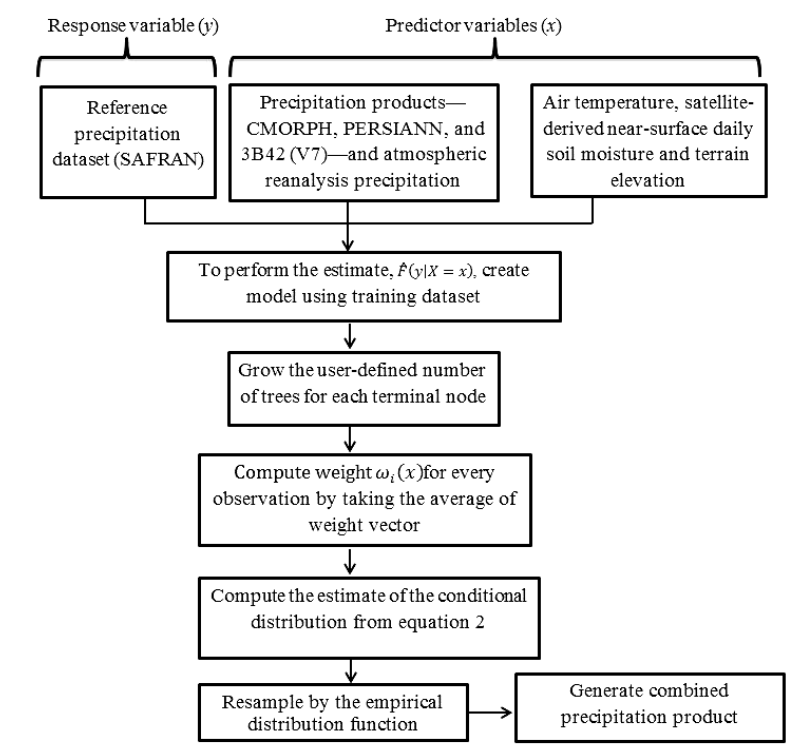
Figure 2. A schematic representation of the quantile regression forests (QRF) framework